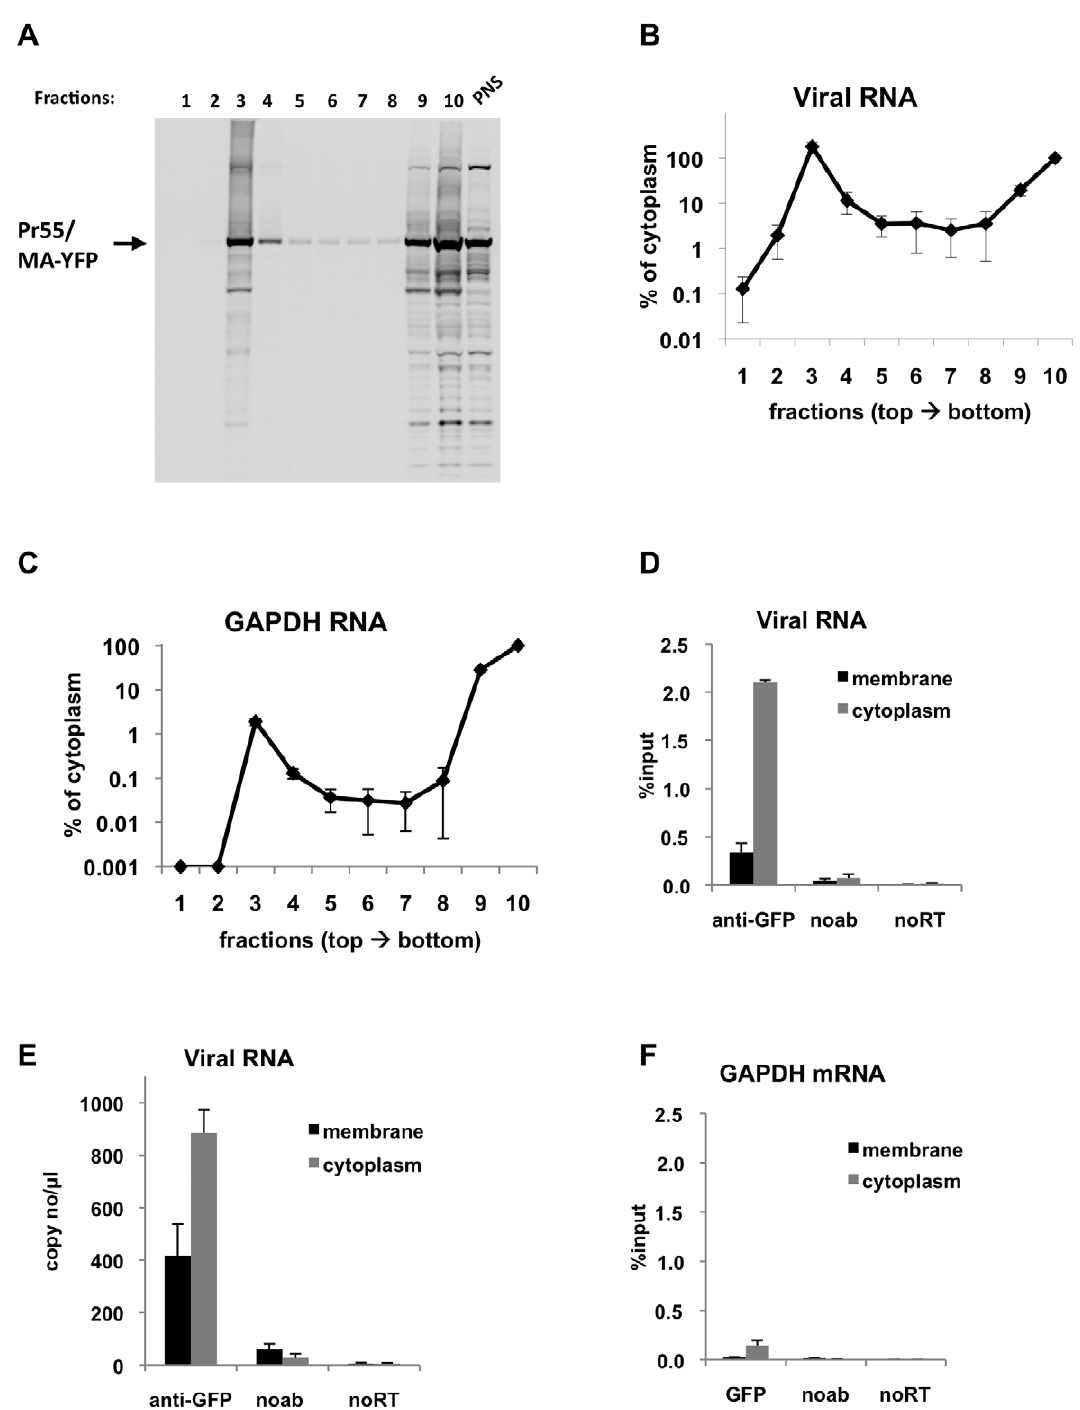
Figure 4. Immunoprecipitation of genomic viral RNA from membrane and cytoplasmic fractions of HIV-1 infected MT2 cells. ( A-F ) MT2 cells were infected with VSV-G pseudotyped NL4-3 MA-YFP/PR- at MOI=1 and processed for subcellular fractionation at 48-h post-infection. Ten fractions from the top of the membrane flotation gradient were collected. Total RNA and proteins from these fractions were isolated as explained in Materials & Methods. ( A ) Western blot analysis of MA-YFP Gag in sucrose fractions and in post-nuclear supernatant (PNS) using anti-HIV-1 CA antibodies. ( B and C ) Viral (B) and GAPDH (C) RNA in fractions was quantitated by qRT-PCR. Data is represented as the relative number of copies of cDNA as compared to the tenth, cytoplasmic fraction sample that was arbitrarily set to a value of 100%. ( D-F ) Immunoprecipitations from the membrane (black bars) and cytoplasmic (gray bars) fractions were performed using anti-GFP antibodies. Parallel immunoprecipitations without antibodies (noab) were included as controls. Immunoprecipitated viral RNA (D and E) or GAPDH RNA (F) was quantitated by qRT-PCR and is represented as either fraction of input material prior to immunoprecipitation (% input) or number of copies of cDNA per m l of PCR template. Data in (B-F) represents the average of two independent experiments where error bars indicate the range. noRT= as explained in legend to Figure 1.